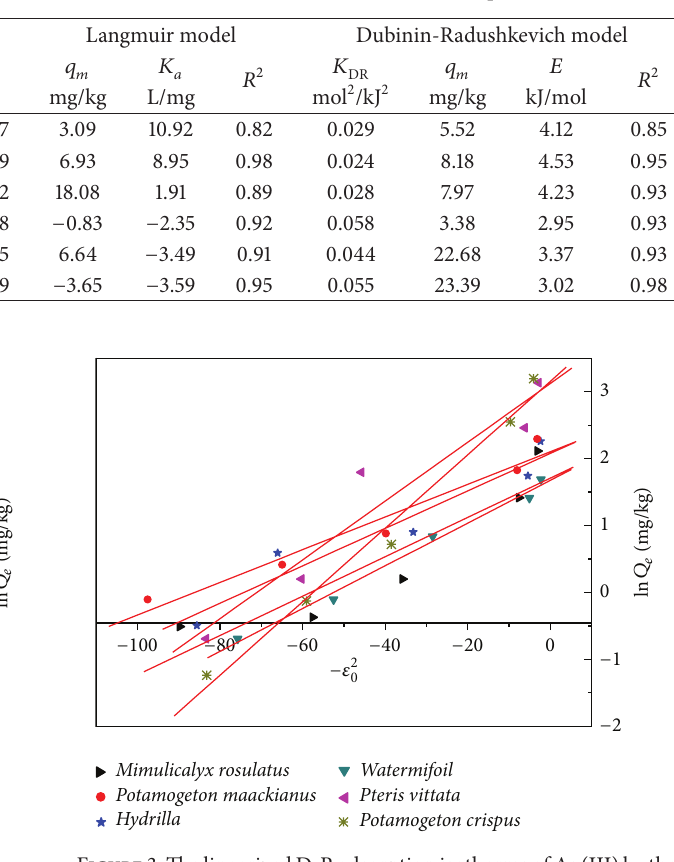
Figure2:ThelinearizedFreundlichadsorptionisothermsofAs(III) by the submerged plants.